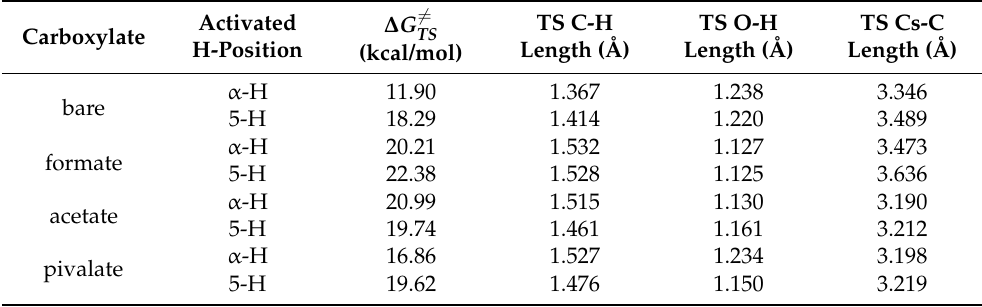
Table 3. Important parameters for C–H activation step for alternative